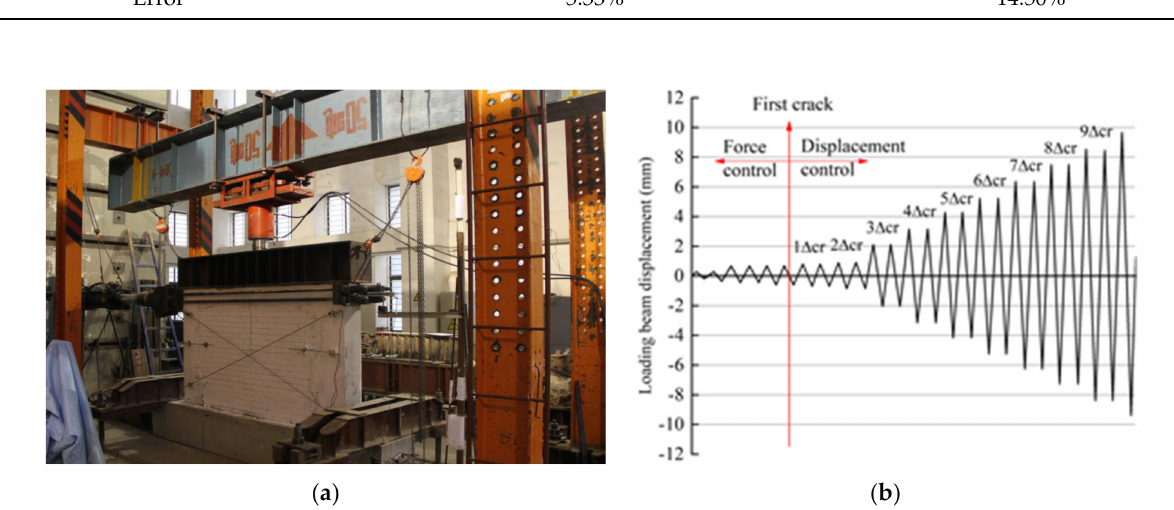
Figure 13. Loading test-piece: ( a ) test setup; ( b ) lateral loading